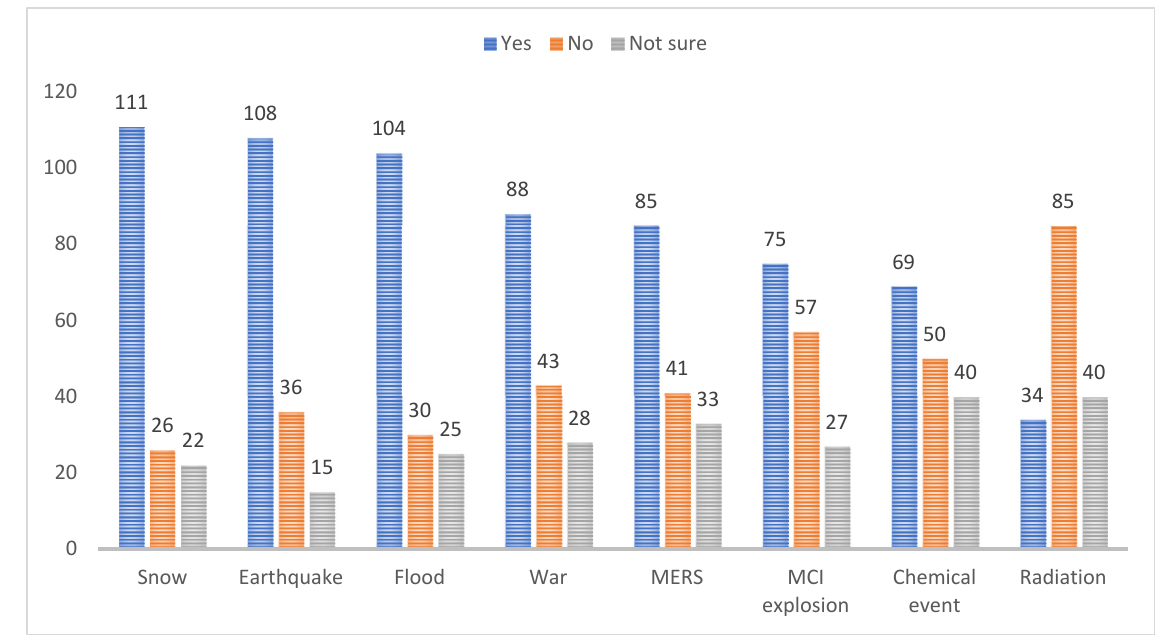
Figure 2. Willingness to respond by disaster events.